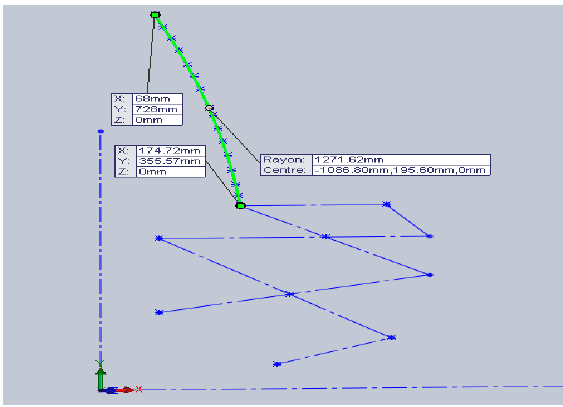
Figure 6. Optimization of the mechanism geometry with the trajectory.